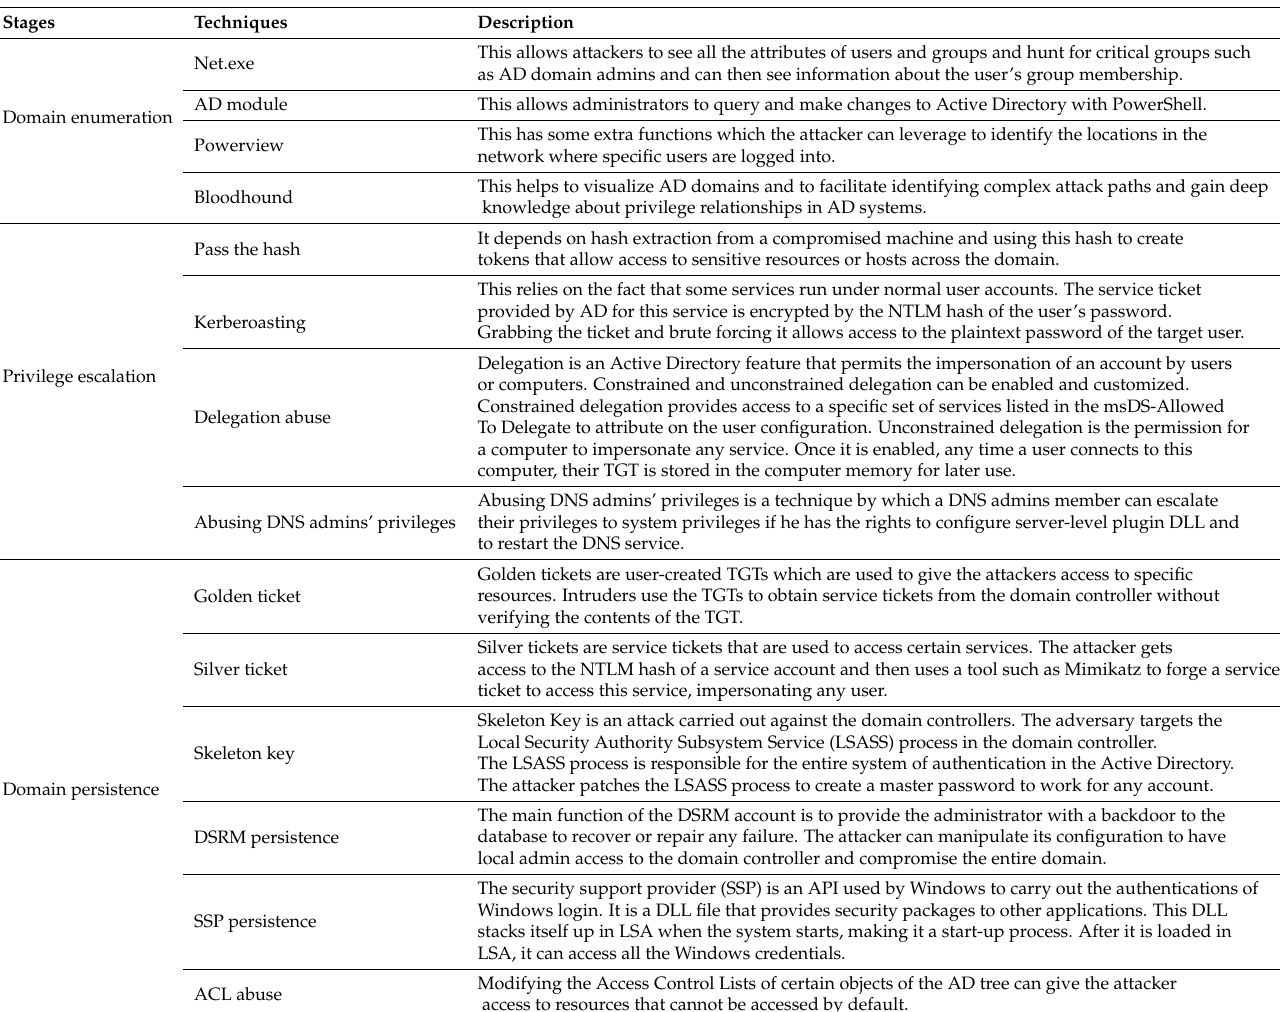
Table 3. Active Directory Attacks Stages and Techniques